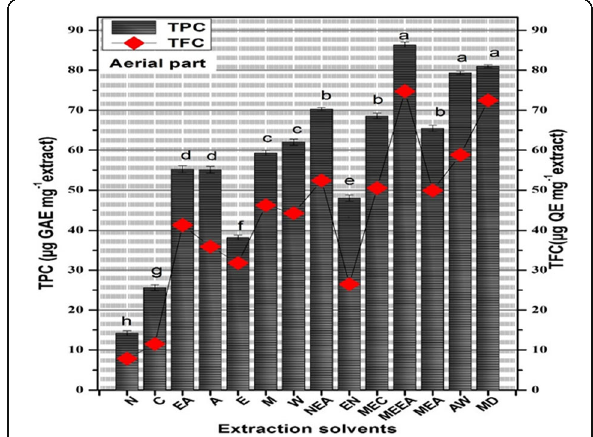
Fig. 2 Total phenolic content and flavonoid content determination of aerial part of A. lasiantha. Results were presented as mean ± S.D. ( n = 3). N: n-hexane, C: Chloroform, EA: Ethyl acetate, A: Acetone, E: